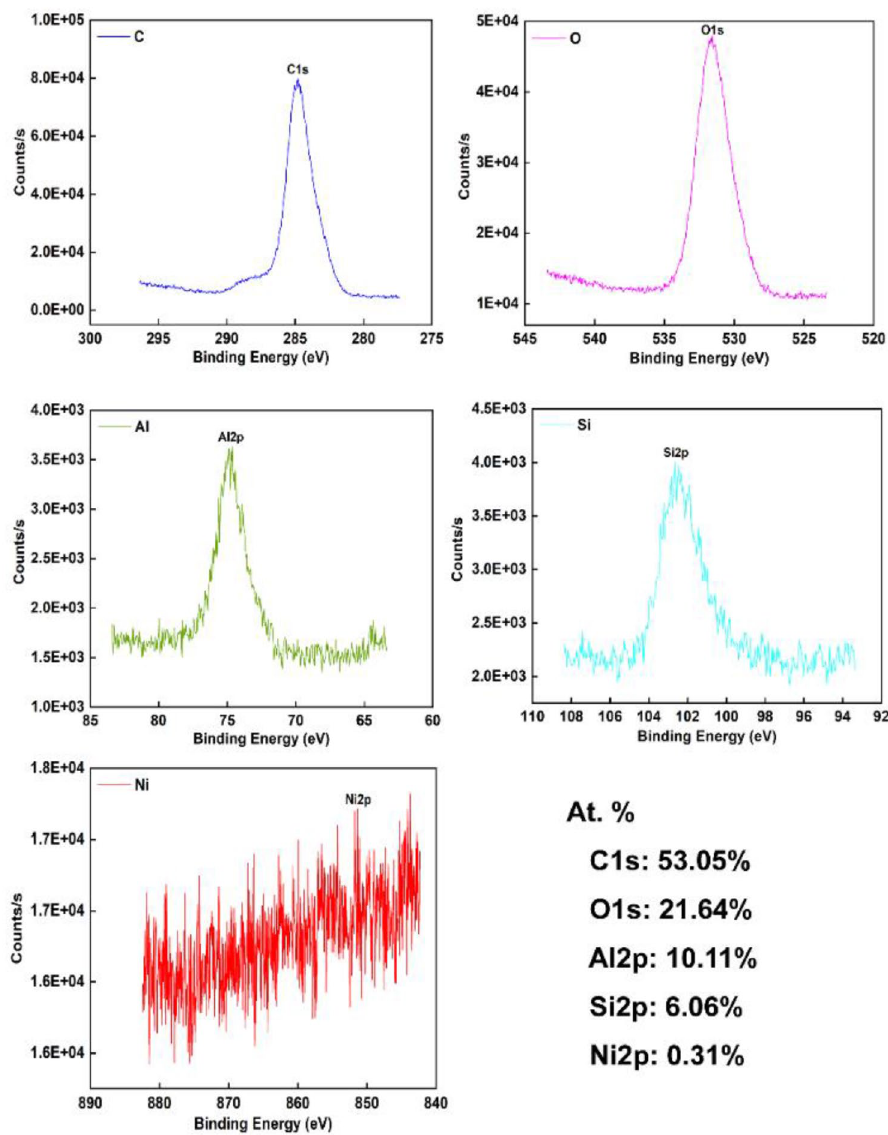
Figure 6. XPS results of the MAO coating prepared by 1.2 g/L NCNs (OriginPro 2018, https:// www. origi nlab. com/ index. aspx? go= Produ cts/ Origin; Adobe Illustrator CS5, https:// www. adobe. com/ cn/ produ cts/ illus trator. html#